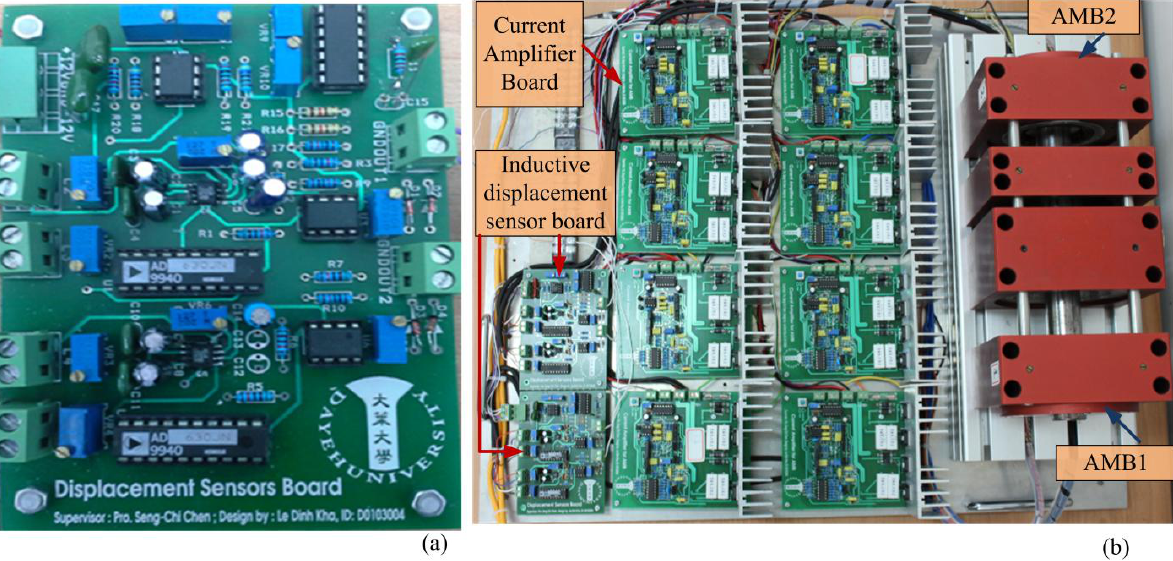
Figure 17. ( a ) Experimental layout board; ( b ) AMB test rig